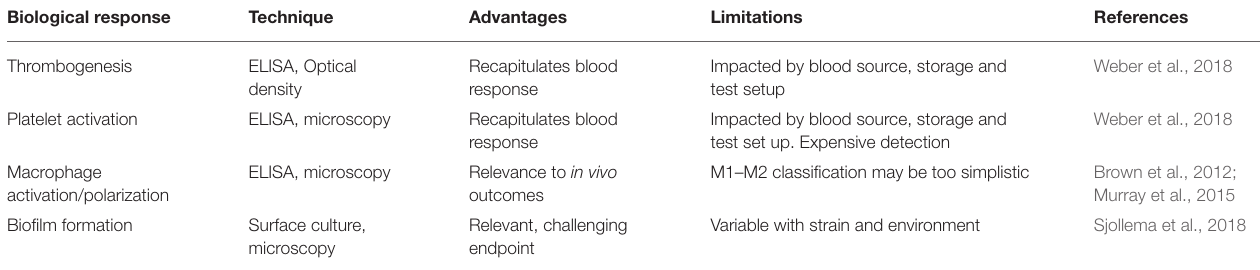
TABLE 3 | Techniques for the characterization of biological responses to biomaterial